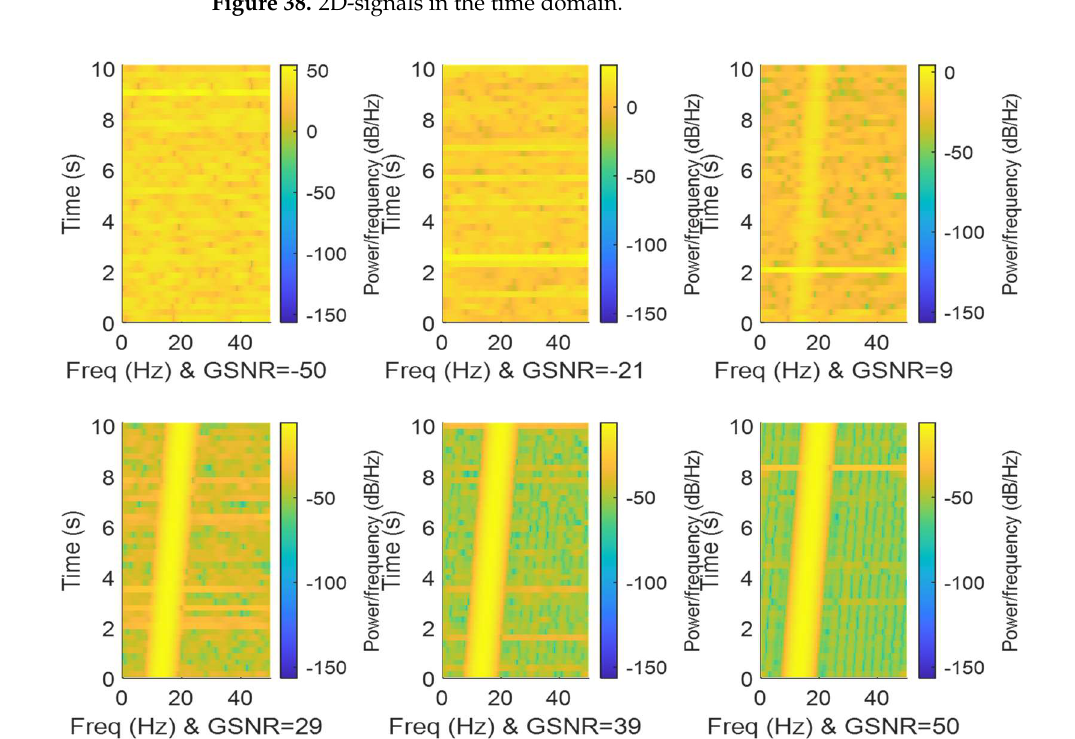
Figure 39. Signals in the time–frequency distribution.